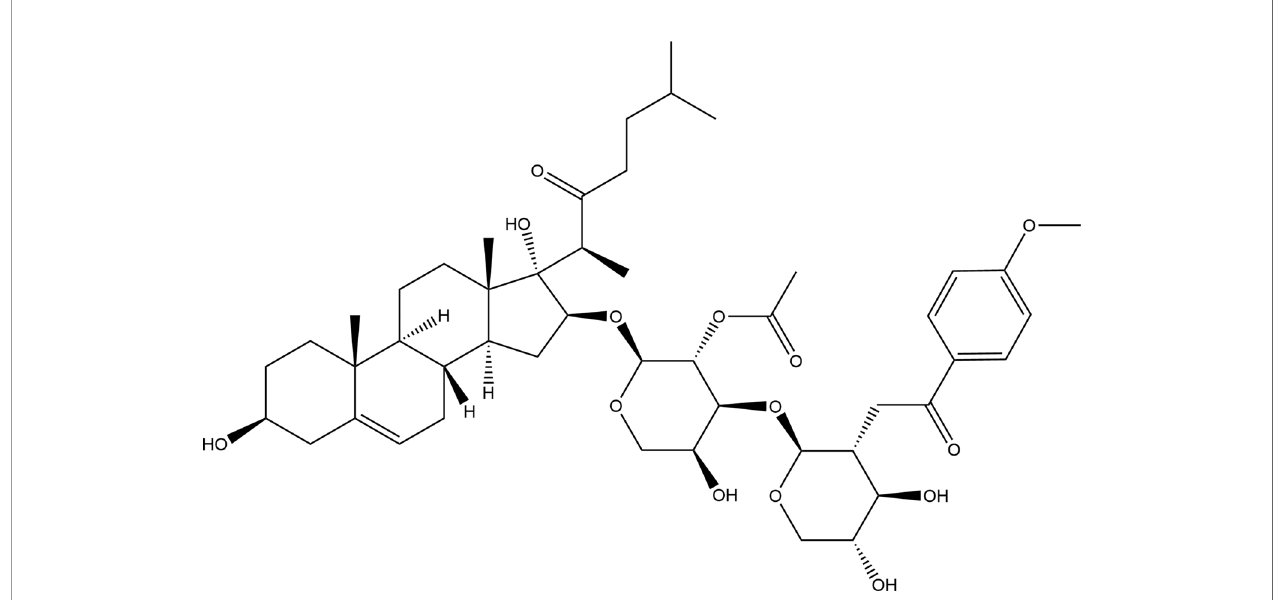
FIGURE 1 | The chemical structure of